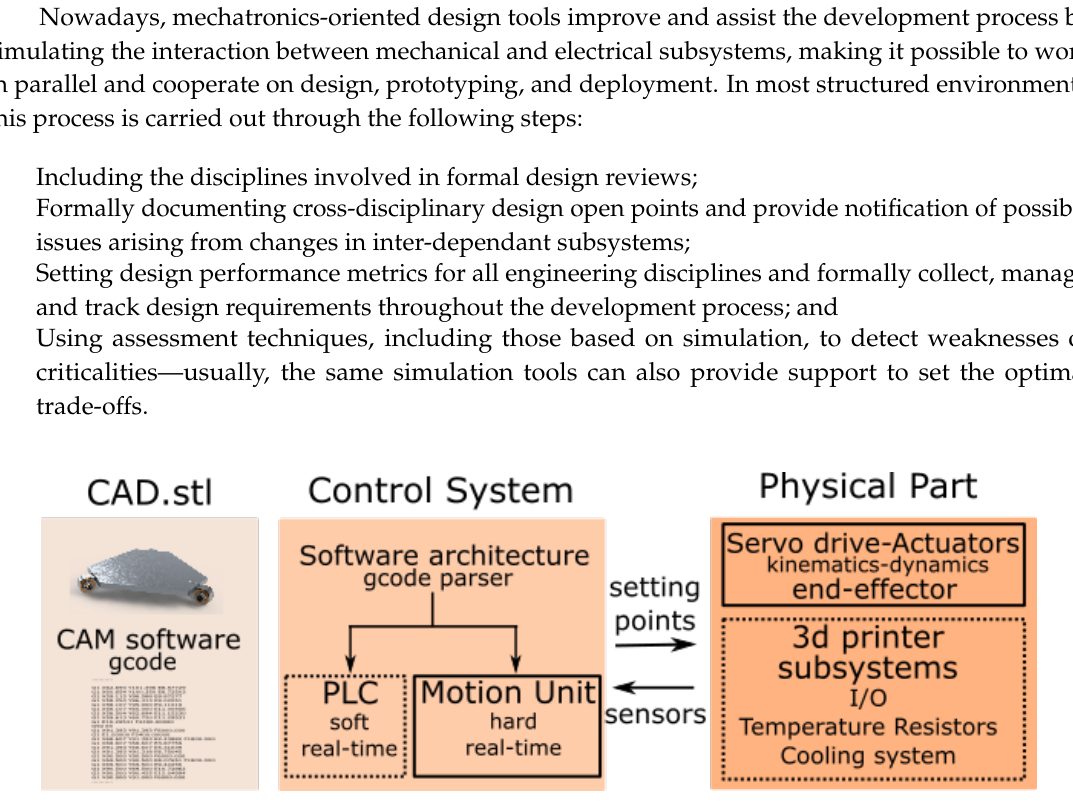
Figure 2. Scheme of the concept